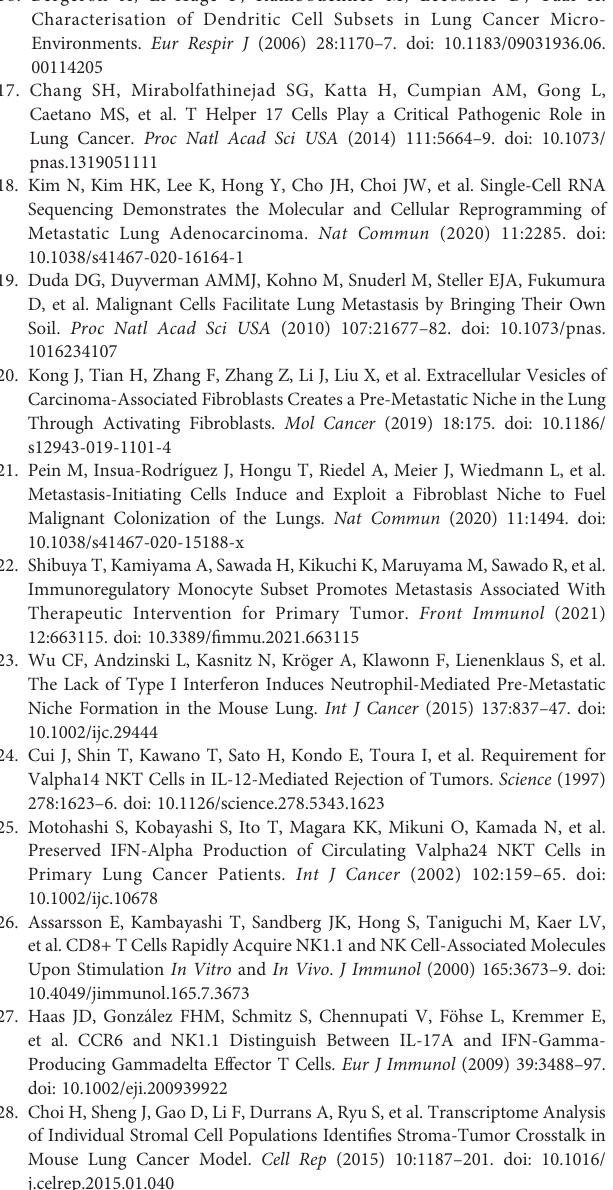
Supplementary Figure S1 | Gating tree for multispectral fl ow cytometry analysis of murine lung. Hierarchical analysis approach for pulmonary cell subsets